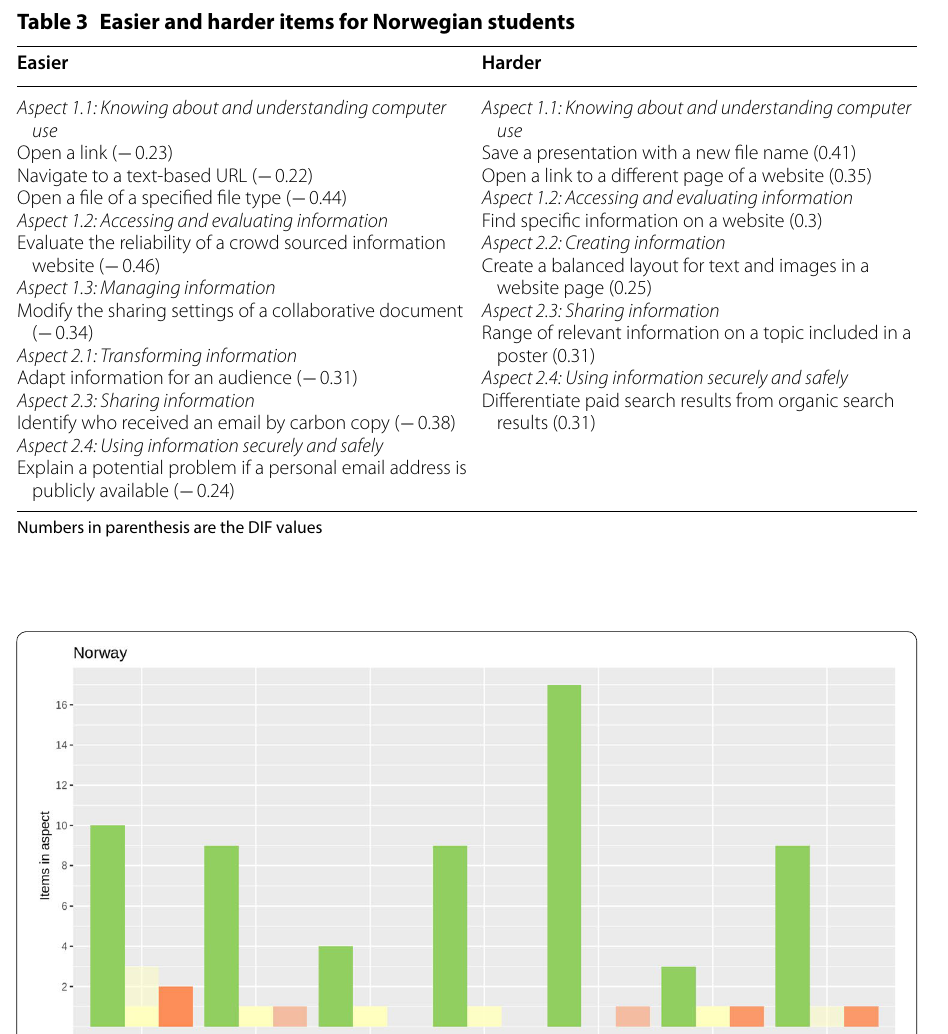
Table 3 Easier and harder items for Norwegian students Easier Harder Aspect 1.1: Knowing about and understanding computer use